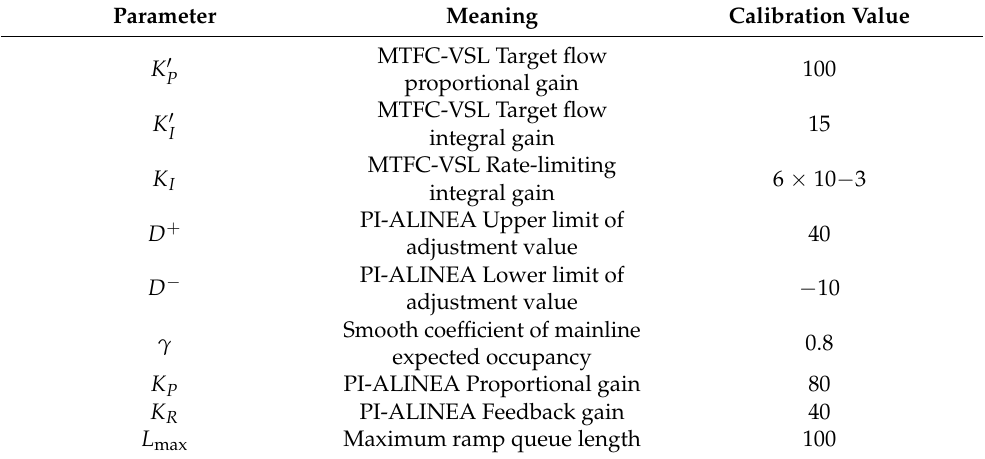
Table 6. MPC parameter calibration results.